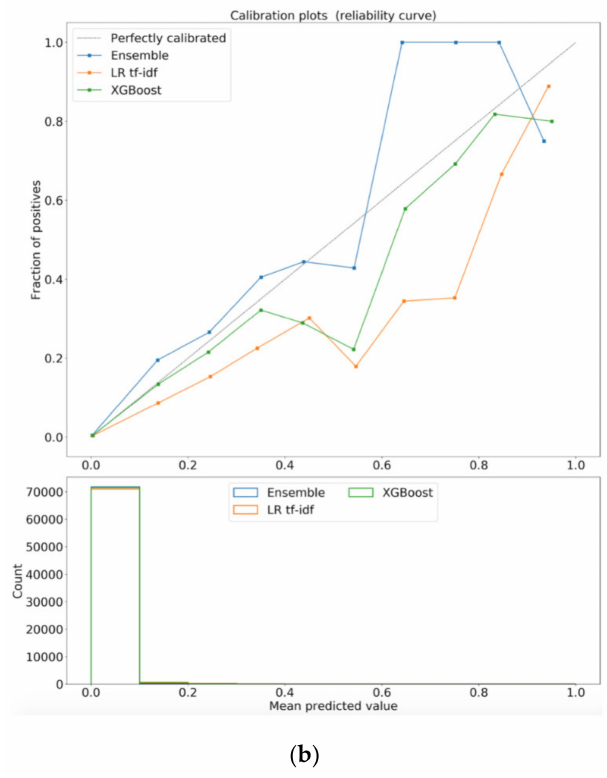
Figure 5. ( a ) Calibration plots for predicting in-hospital mortality within 48 h ( b ) Calibration plots for predicting overall in-hospital mortality.